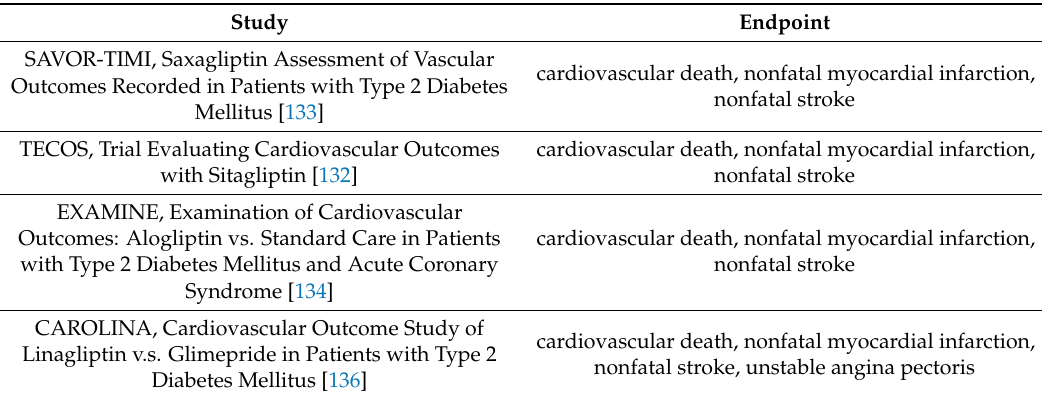
Table 2. Meta-analyses of clinical trials using DPP4